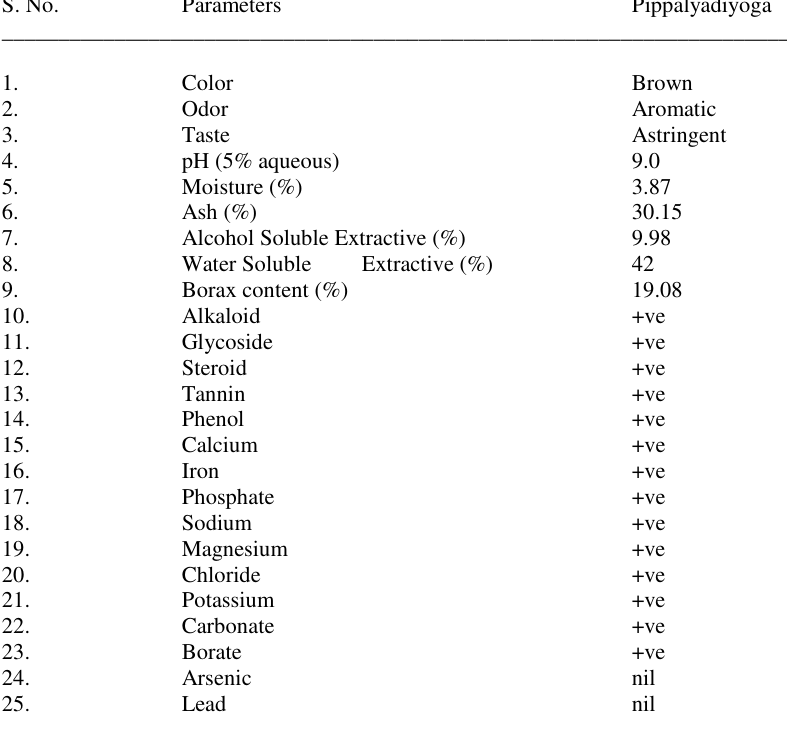
Table 1 . Data of physico-chemical analysis of pippalyadiyoga S. No.